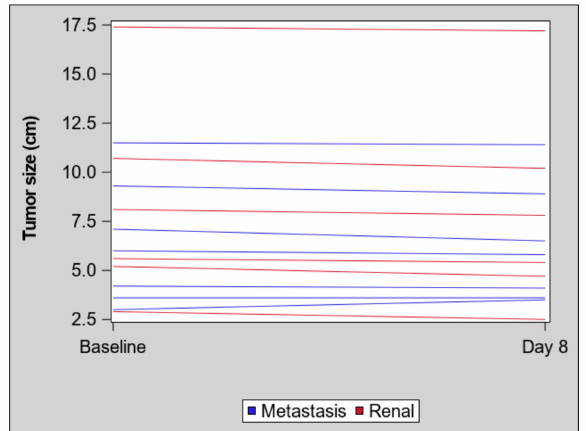
Figure 1. No significant change in tumor size by tumor location after eight days of treatment. Spaghetti plot of the maximum diameter (cm) of each tumor (primary renal mass: red; metastases: blue) at baseline and eight days after initiating treatment. Each line represents a single mass.